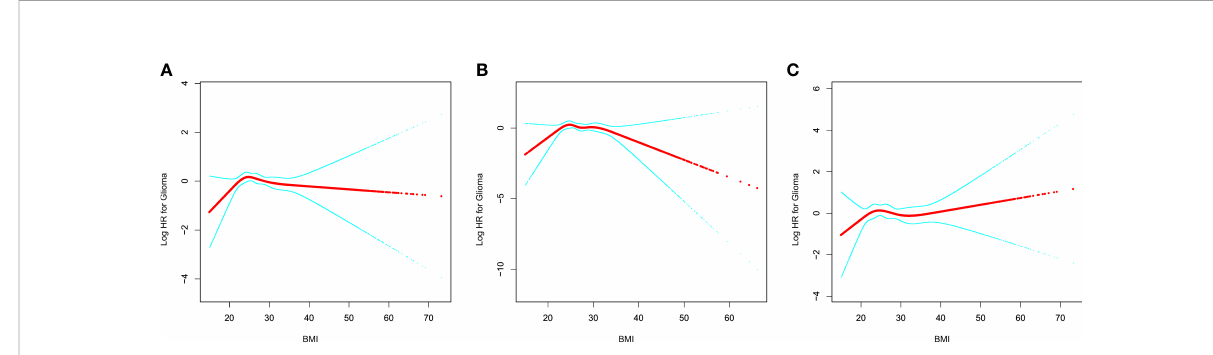
FIGURE 1 The relationship between glioma risk and BMI. (A) All participants; (B) men; (C) women. Adjusted for age (smooth), sex, race, marital status, education, smoking, and height. For women, the risk estimates were additionally adjusted for OC (never vs. ever use) and HRT (never vs. ever use). BMI, body mass index; OC, oral contraceptive; HRT, hormone replacement